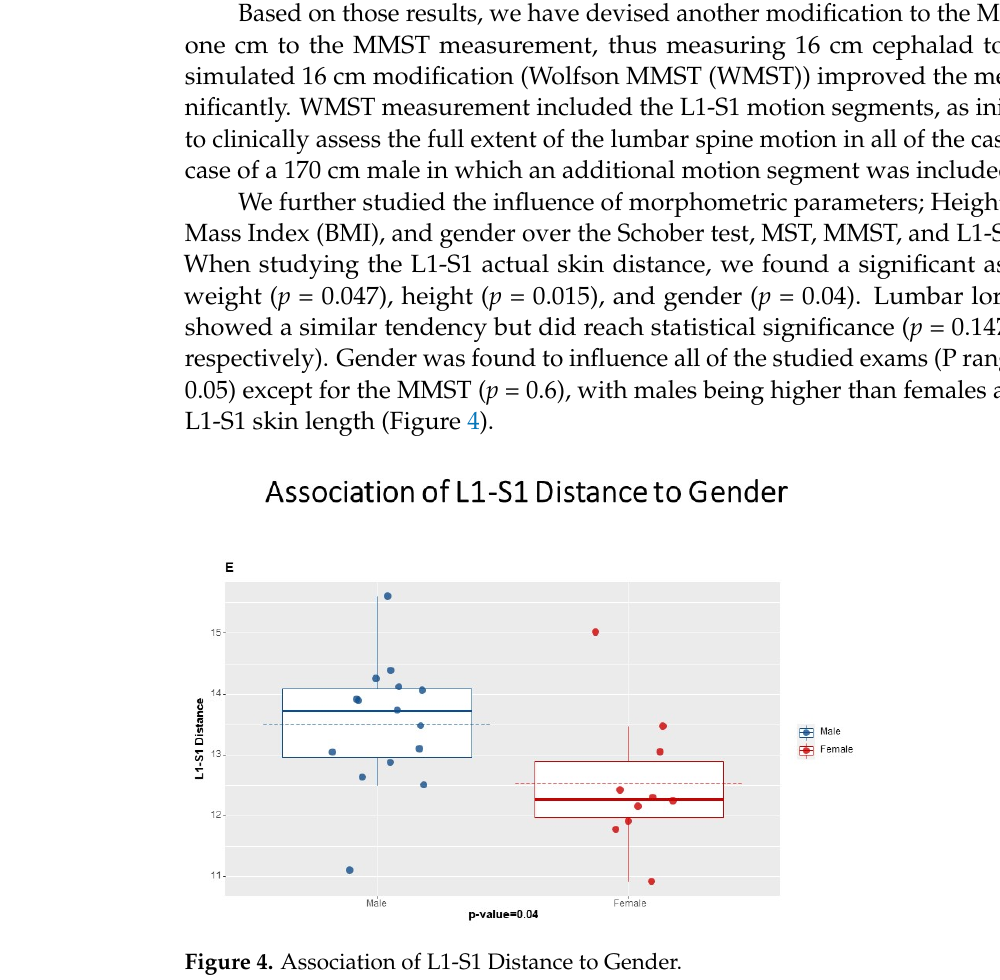
Figure 4. Association of L1-S1 Distance to Gender.